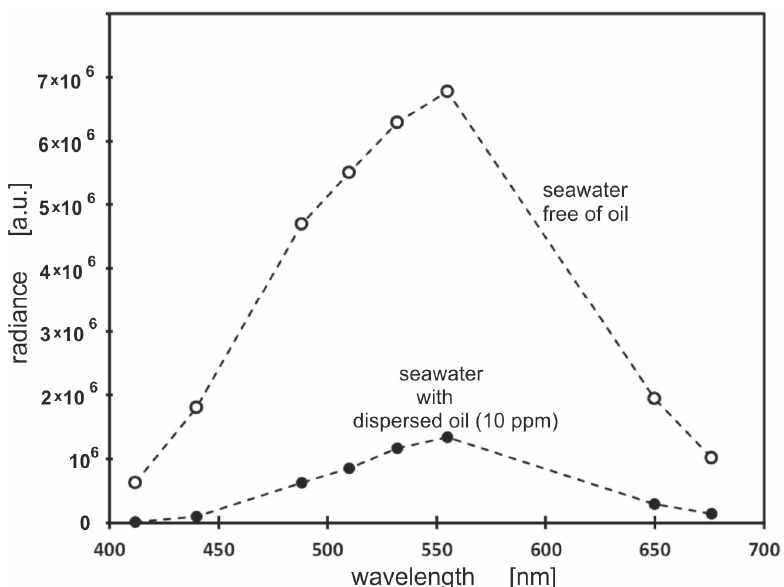
Figure 6 . The radiance under the sea surface for eight wavelengths: 412 nm, 440 nm, 488 nm, 510 nm, 532 nm, 555 nm, 650 nm and 676 nm, for unpolluted seawater (white dots) and seawater polluted with an oil-in-water emulsion (10 ppm) (black dots).